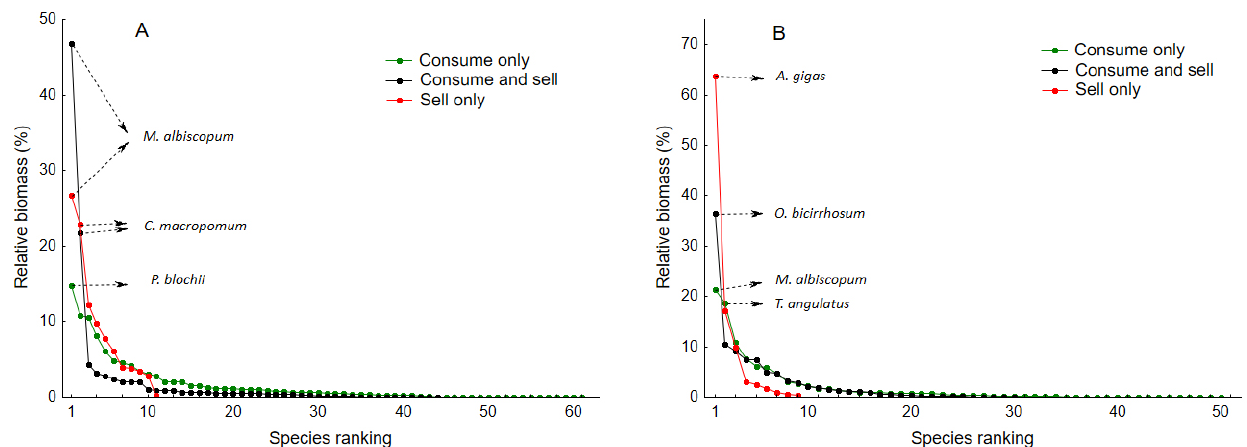
FIGURE 4 | Fish species rank curve (by percentage biomass), during the ( A ) high-water and ( B ) low-water seasons. ( A ) Mylossoma albiscopum and Colossoma macropomum dominate high water catches, both for sale only (red) and for both sale and consumption (black). These species are also both important in catches for consumption only (green), but Pimelodus blochii is the most important species in this category. ( B ) Arapaima gigas dominates low-water season commercial fish catches (red), Osteoglossum bicirrhosum in catches for both consumption and sale (black), and Mylossoma albiscopum (= M. duriventre ) and Triportheus angulatus in catches for consumption